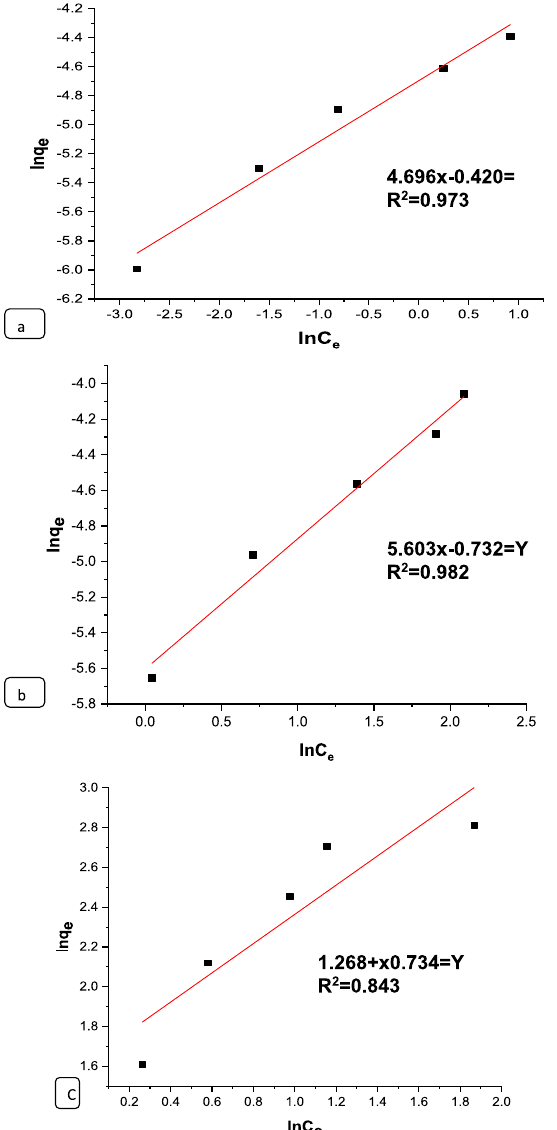
Fig. 18 Freundlich a nano-bentonite, b MgO impregnated clay and c raw bentonite plots for adsorption of MG